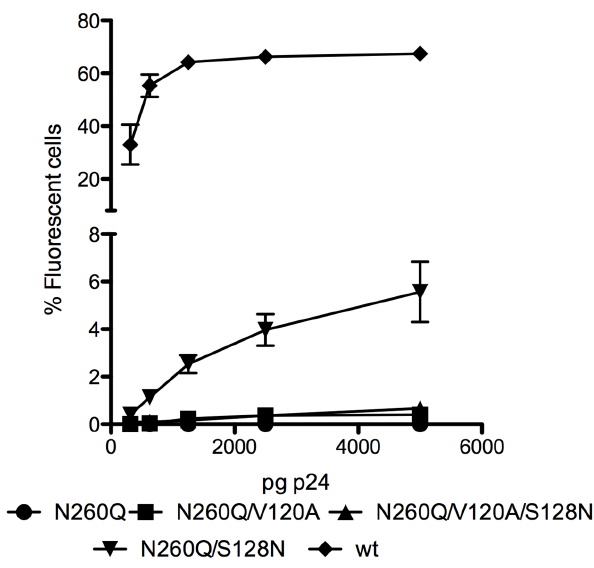
Figure 4. Ribbon diagram representation of core gp120 with indication of Asn260 and Ser128. In the shown orientation, the viral envelope would be on top of the picture and the cellular target membrane on the bottom of the picture. Asn260 is positioned in the C2 region. Ser128 can be found at the base of the V1/V2 loop region. Amino acid numbering is based on HIV-1 strain NL4.3, and corresponds with amino acids Asn262 and Ser128 in HIV-1 strain HXB2. Figure adopted from Kwong et al . 1998